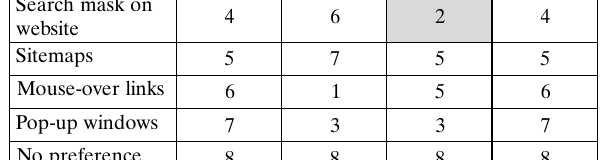
Fig 3. Sony Ericsson’s US website